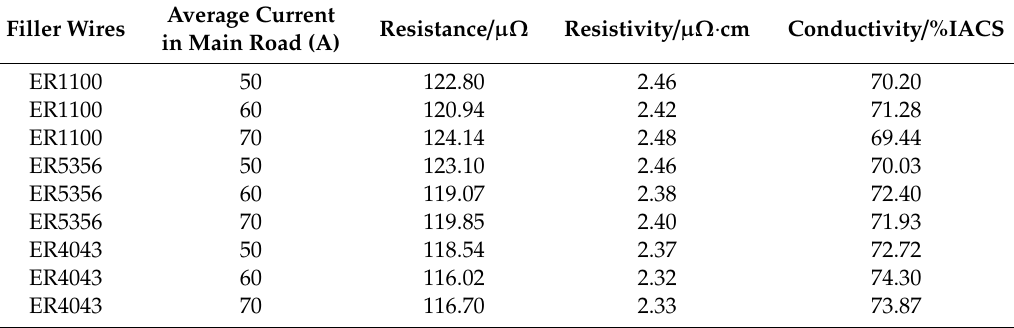
Table 10. Electrical conductivity of aluminum / copper melt welding